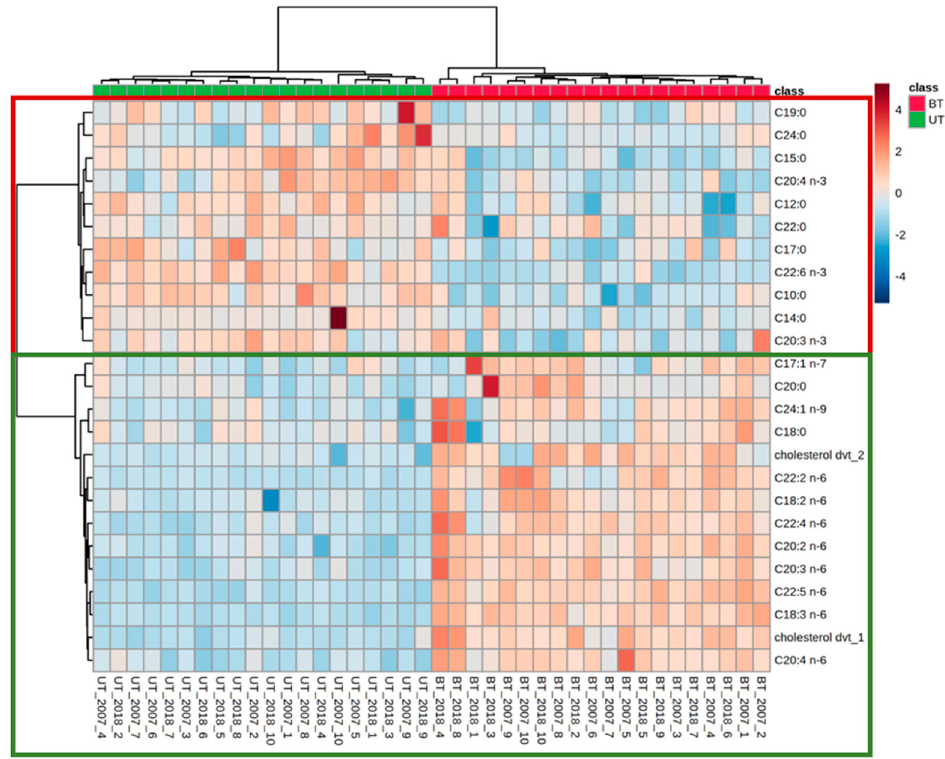
Figure 6. Heat map using top 25 features of boar–tainted (BT) and untainted (UT) pig serum.